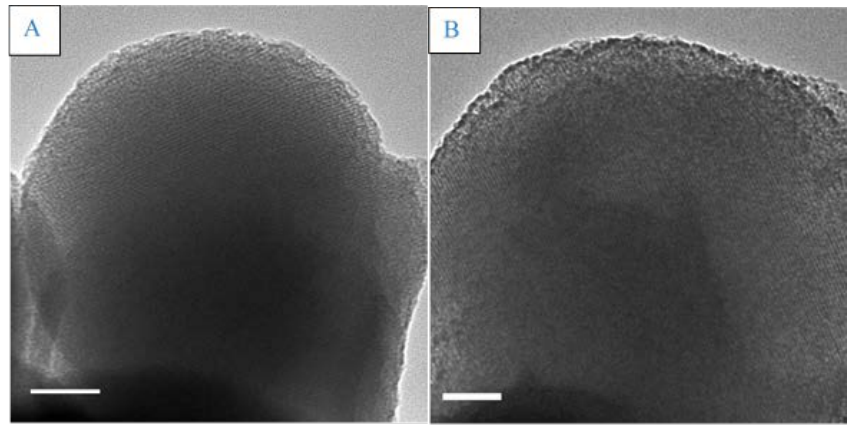
Figure 4. Representative TEM images of ( A ) TiO 2 -MCM-48-B-200 ( left ) and ( B ) TiO 2 -MCM-48-B-10 ( right ). The bar scale is 50